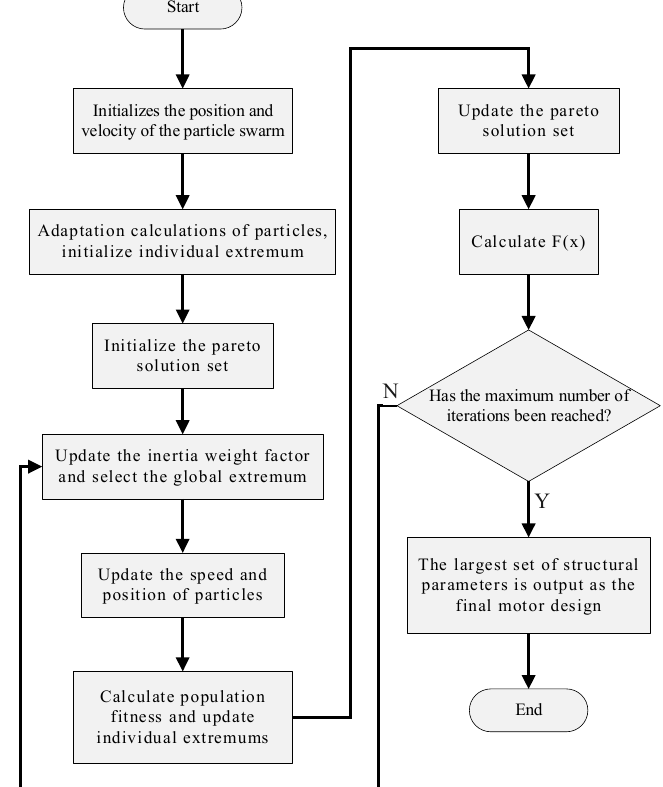
Figure 15. Flow block diagram of the particle swarm optimization algorithm.